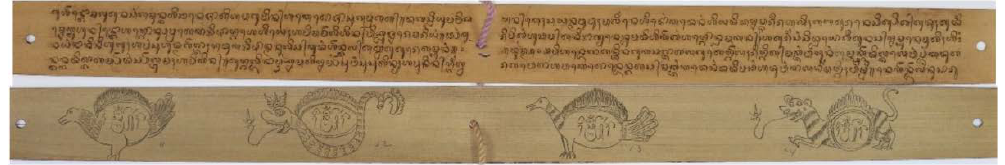
Figure 1. Balinese palm leaf manuscripts.